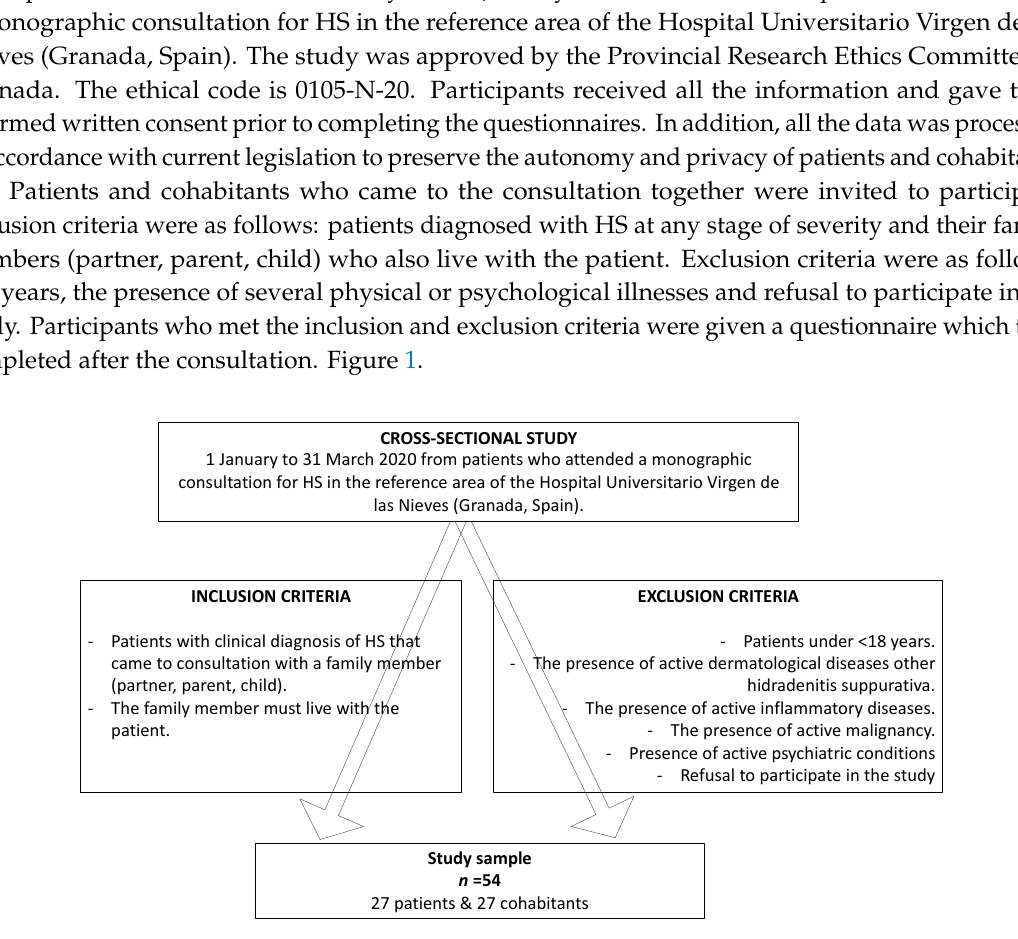
Figure 1. Flowchart . Inclusion and exclusion criteria. Figure 1. Flowchart. Inclusion and exclusion